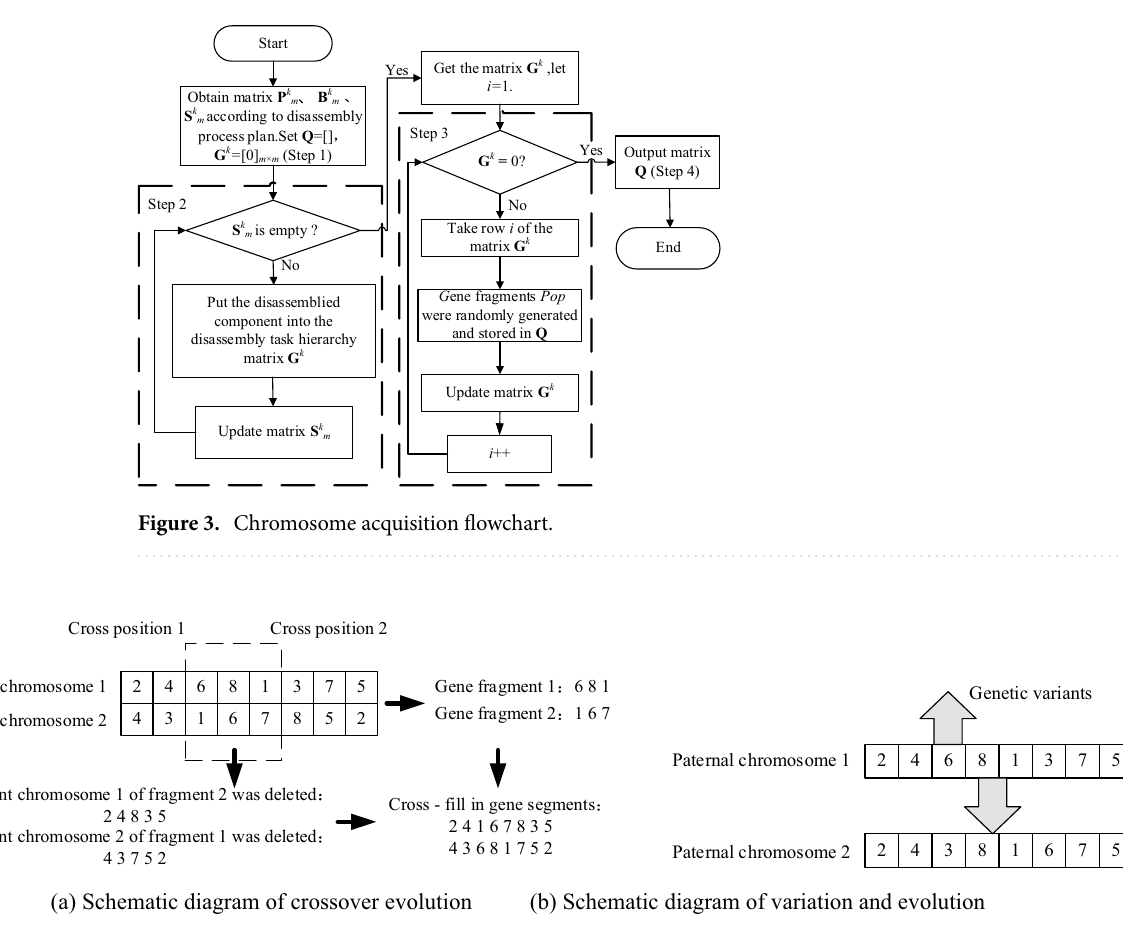
Figure 4. Schematic crossover and variation